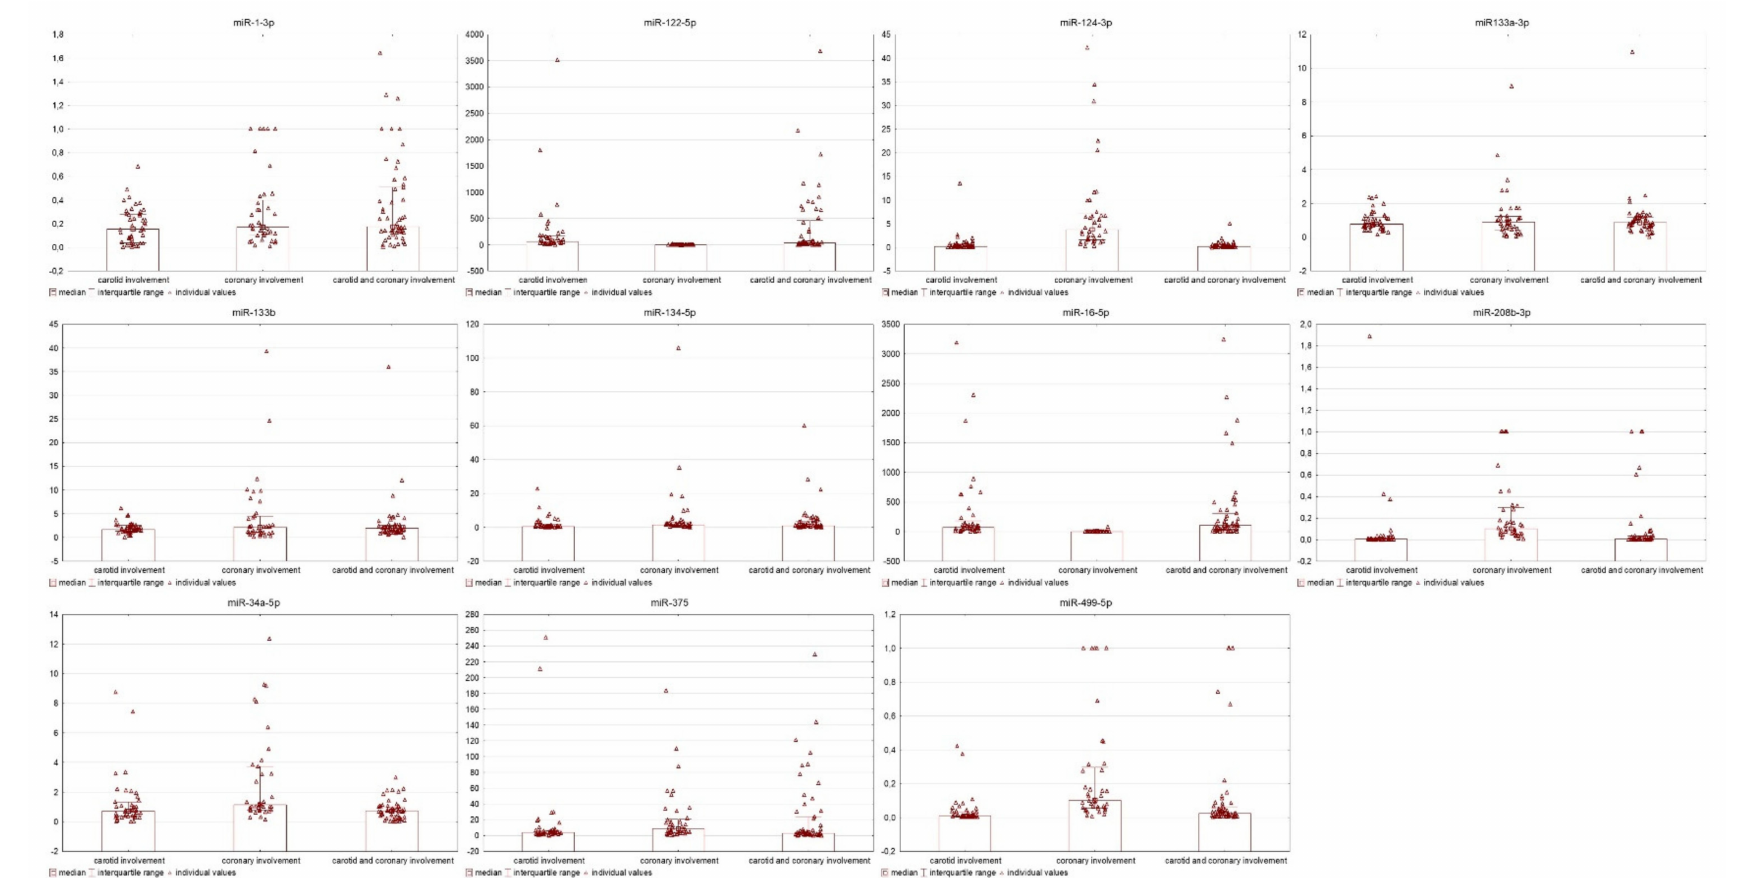
Figure 2. Detected miRs for every study group (carotid involvement, coronary involvement and carotid and coronary involvements) shown as dot plot bar-graphs with individual dots of each individual patient to find the tendency of miRs expressions in each group. Each dot represents one